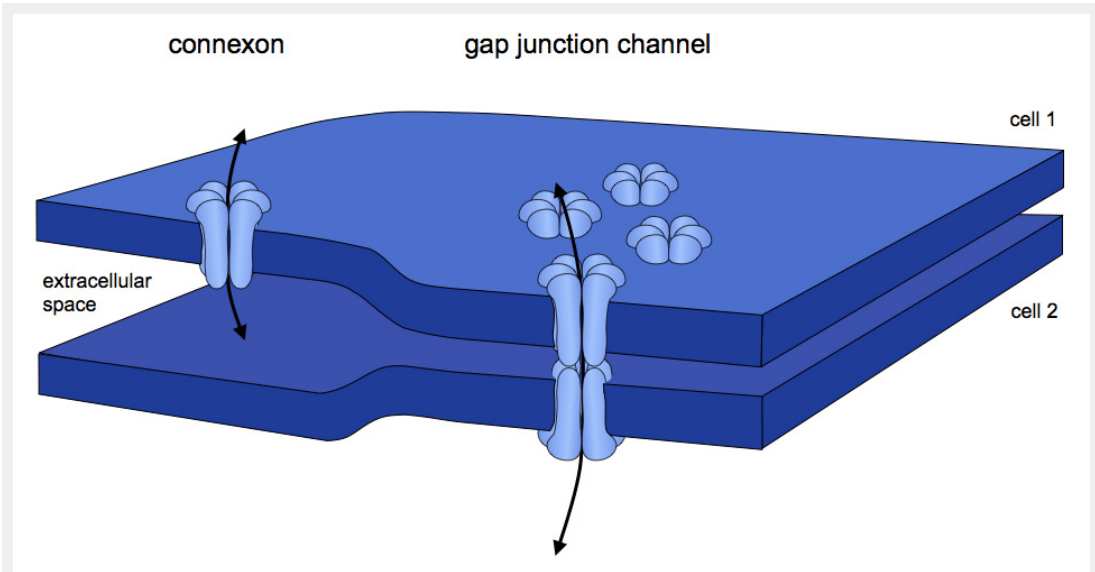
Figure 1 Connexins form connexons composed of six connexins in the Golgi apparatus. Thereafter, connexons can be inserted in the plasma membrane where they can function as connexons (hemi-channels; left) or as gap junctions (right) if they dock to a connexon expressed by a neighbouring cell. Connexons allow exchange of small molecules (<1000 Da) between the cytosol and the extracellular space. Gap junctions allow passage of similar molecules between adjacent cells.